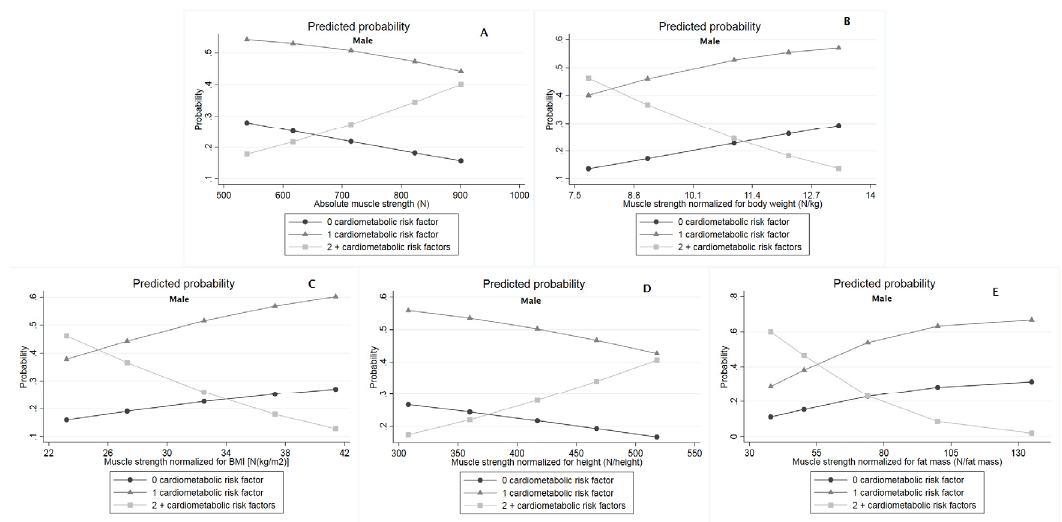
Figure 2. Predicted probability from a multinomial logistic model for the adjusted relationship between muscle strength indices with cardiometabolic risk factors among males. ( A ) Absolute muscle strength (N); ( B ) Muscle strength normalized for body weight (N/kg); ( C ) Muscle strength normalized for BMI [N/(kg/m 2 )]; ( D ) Muscle strength normalized for height (N/height); ( E ) Muscle strength normalized for fat mass (N/fat mass).